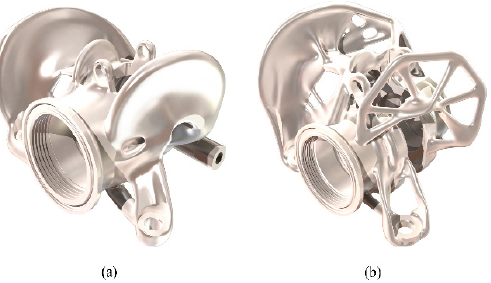
Figure 10. The optimized housings in SolidWorks: ( a ) Front, ( b ) Rear.